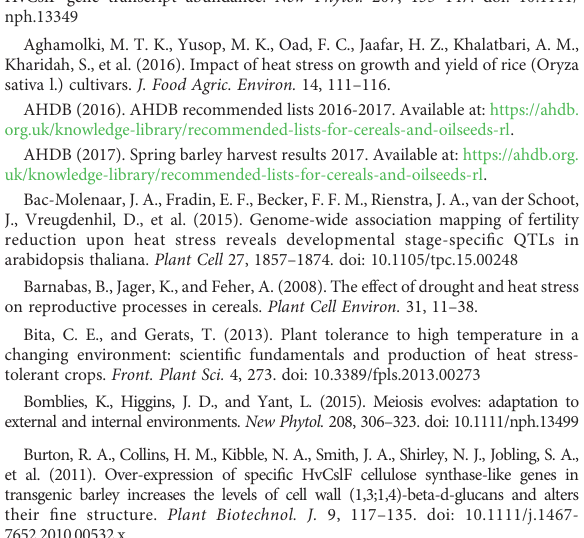
SUPPLEMENTARY FIGURE 5 Immunolabelling of cell wall components in anthers and ovules in Moonshine. Comparison of control and heat stressed anthers and ovules in barley fl orets of the variety RGT Planet. Antibodies include BG1 (1,3;1,4- b -glucan, green) and LM19 (low methylesteri fi ed pectin, red). Calco fl uor White counterstain was used to detect cellulose and mixed-linkage glucan (blue). SUPPLEMENTARY FIGURE 6 Immunolabelling of cell wall components in anthers and ovules in RGT Planet. Comparison of control and heat stressed anthers and ovules in barley fl orets of the variety RGT Planet. Antibodies include BG1 (1,3;1,4- b - glucan, green) and LM19 (low methylesteri fi ed pectin, red). Calco fl uor White counterstain was used to detect cellulose and mixed-linkage glucan